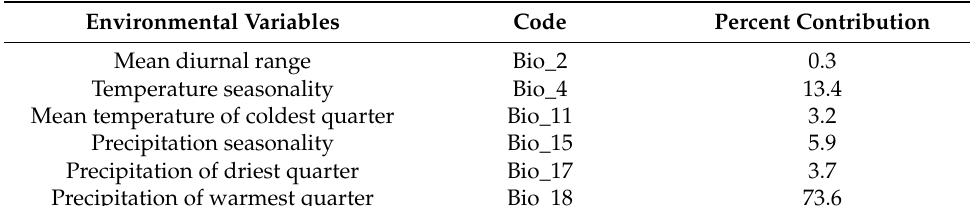
Table 1. Environmental variables used for modeling and their permutation importance.